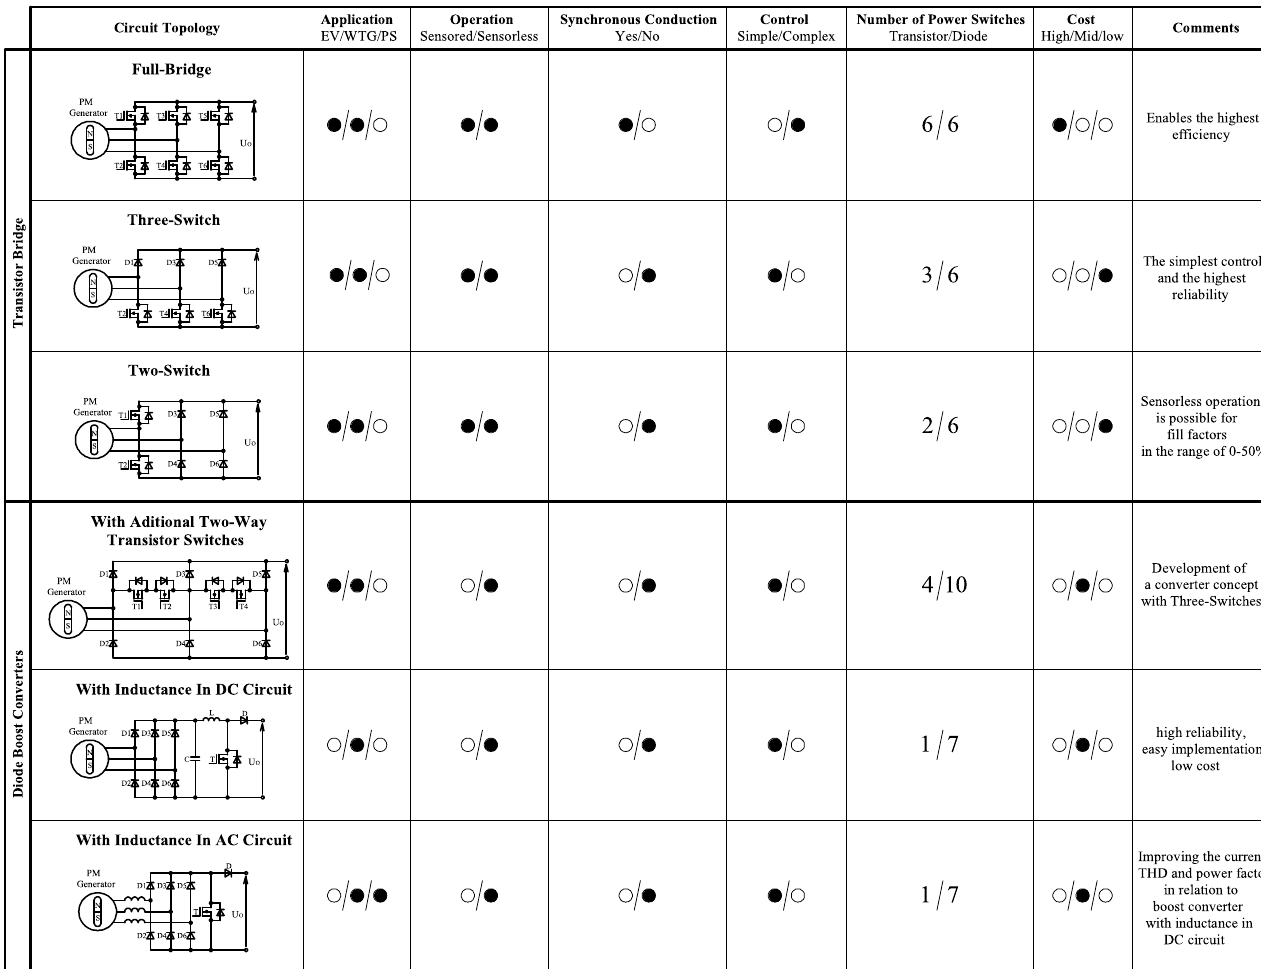
Figure 1. Classification of AC/DC converters for three-phase PM generators. EV—electric vehicle; WTG—wind turbine generators; PS—power supply.